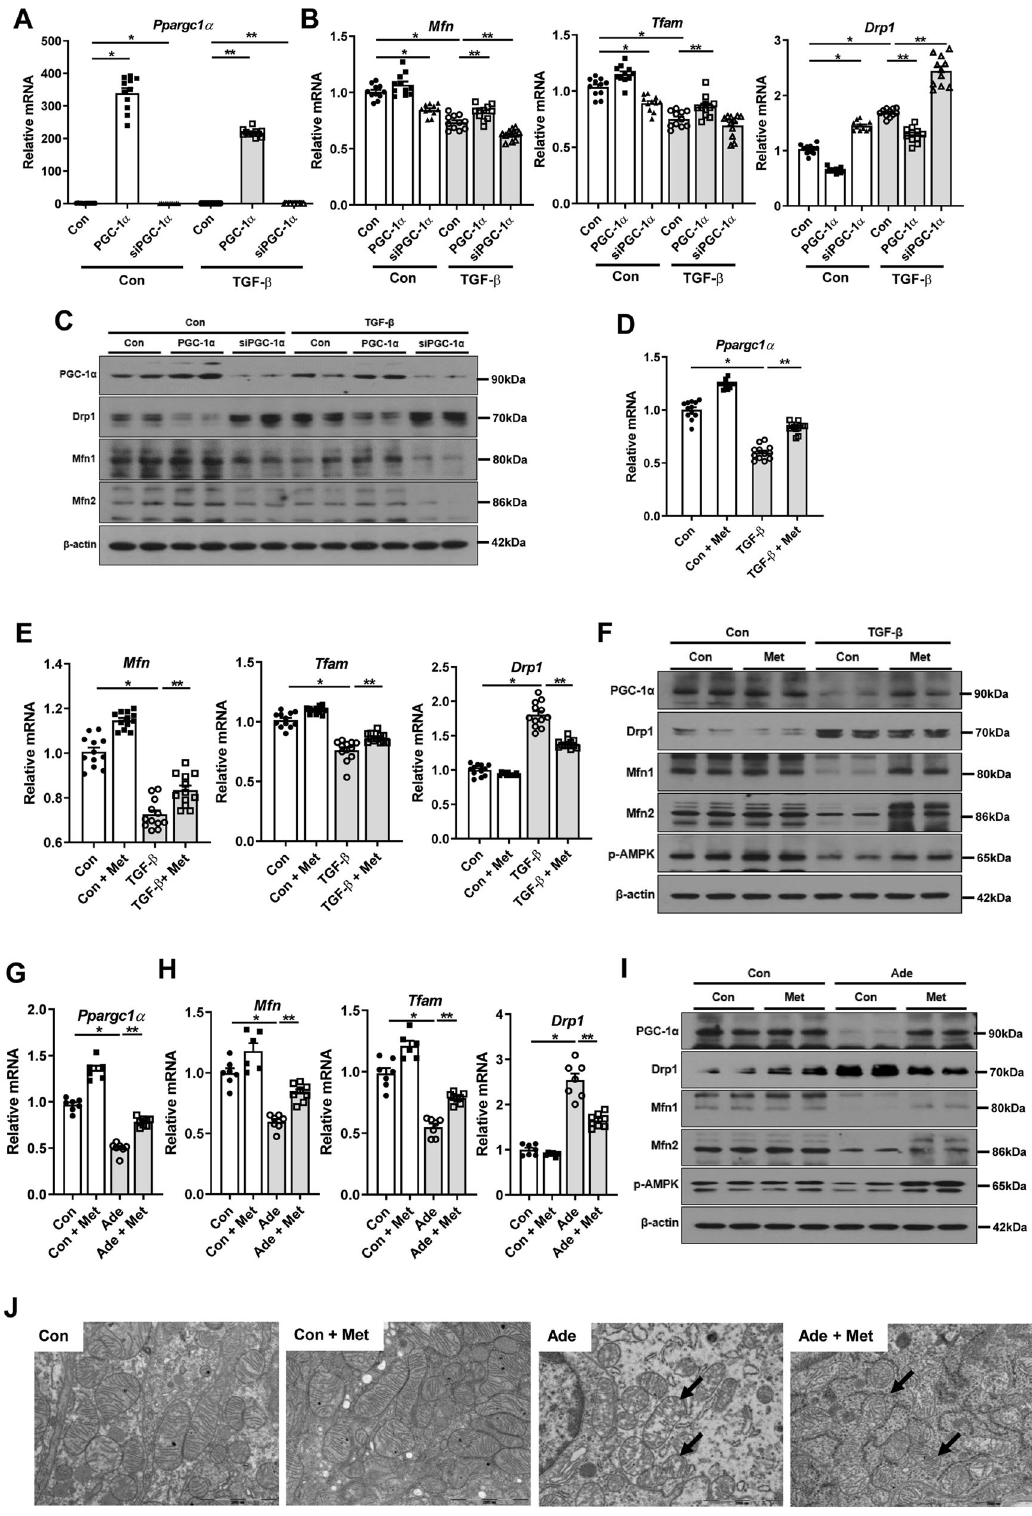
kidney tissue lysates were signi fi cantly decreased by metformin treatment measured by ELISA (Fig. 5H). Given the ability of PGC-1 α to regulate mitochondrial dynamics, we then tested the role of Drp1 in NLRP3 in fl ammasome activation. The NLRP3 in fl ammasome signaling was signi fi cantly